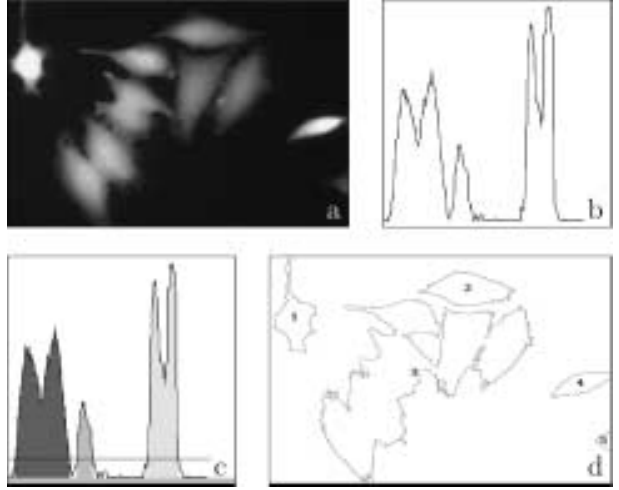
Fig. 4. Initial object detection. A grey-scale image of a cluster of cells is shown in (a). The variation in grey-scale intensity is illustrated by measuring the intensity along a line across (a), as shown in (b). If segmentation by a single threshold followed by labeling of connected components is applied to (a), it is not possible to separate and find all objects at once, as shown in (c) and (d). The different shades of grey represent separate objects in (c). Each number in (d) represents a single object found after thresholding of (a) and labeling of connected components.